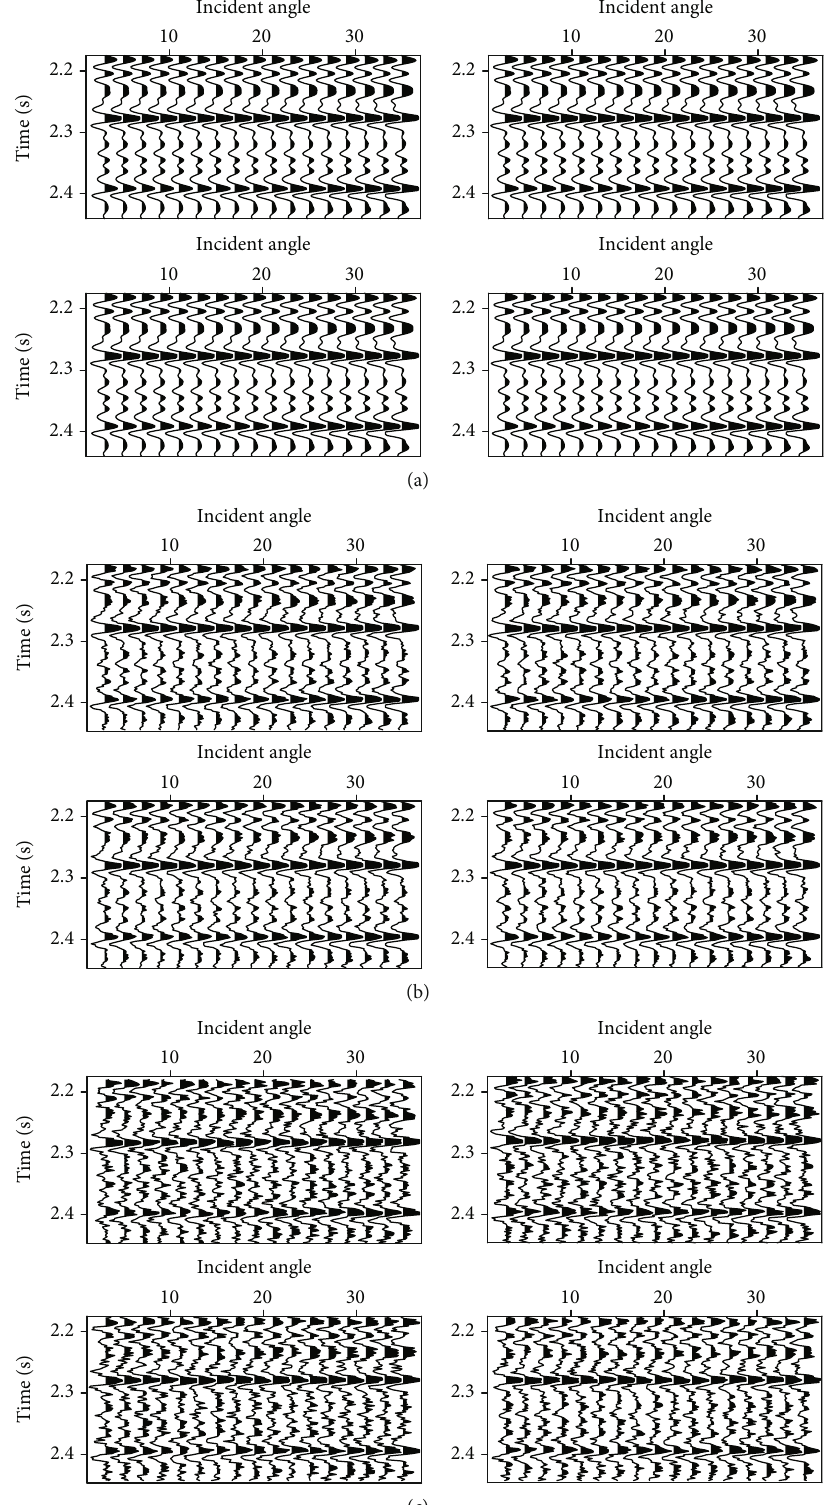
Figure 8: Synthetic azimuthal seismic angles with di ff erent SNRs, where (a) is noise free, (b) is 5, and (c) is 2. Note that the four azimuths are 0 ° , 45 ° , 90 ° , and 135 ° ,